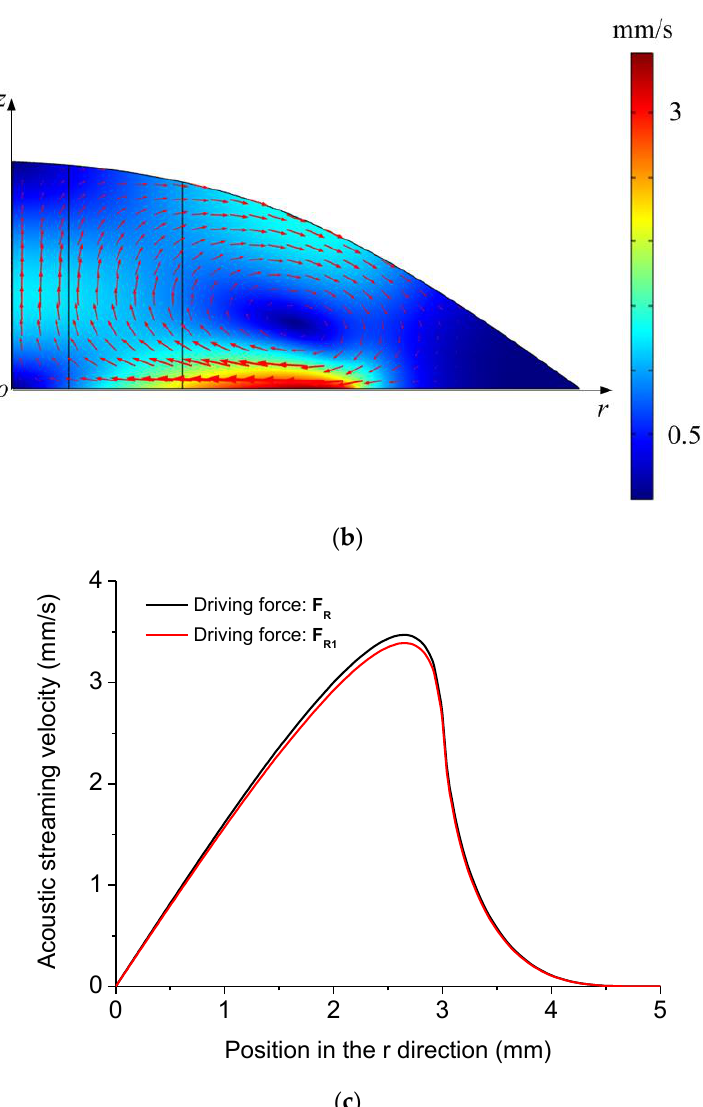
Figure 10. ( a ) Acoustic streaming field in the droplet-ultrasonic substrate system computed by the PM. ( b ) Acoustic streaming field in the droplet-ultrasonic substrate system computed by the RSM. ( c ) Computed acoustic streaming velocity magnitude distribution along the r direction at the droplet-substrate interface in the droplet-ultrasonic substrate system when the driving forces of acoustic streaming are F R and F R 1 , respectively.